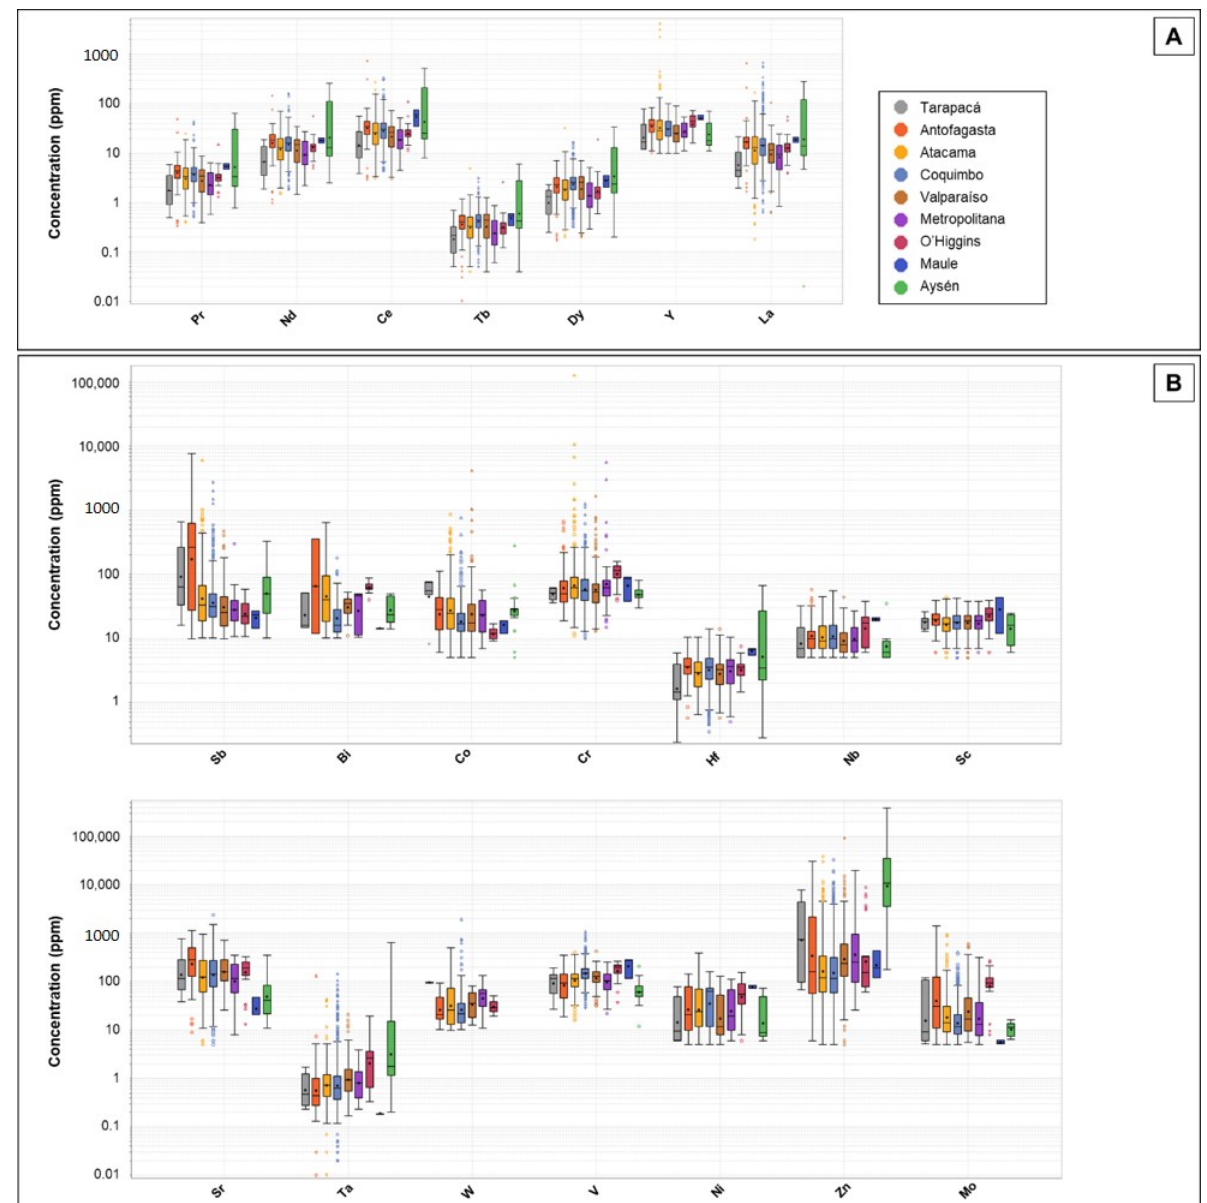
Figure 4. Tukey log-plot graph showing the concentration of the critical elements at each site included in Australia split in ( A ) REEs-Praseodymium, Neodymium, Cerium, Terbium, Dysprosium and Yttrium ( B ) other critical elements. The box is the middle 50% of data from Q1 to Q3. The outliers (circles) are in the top or bottom 5% of the data. The whiskers are the 5% and 95% values.